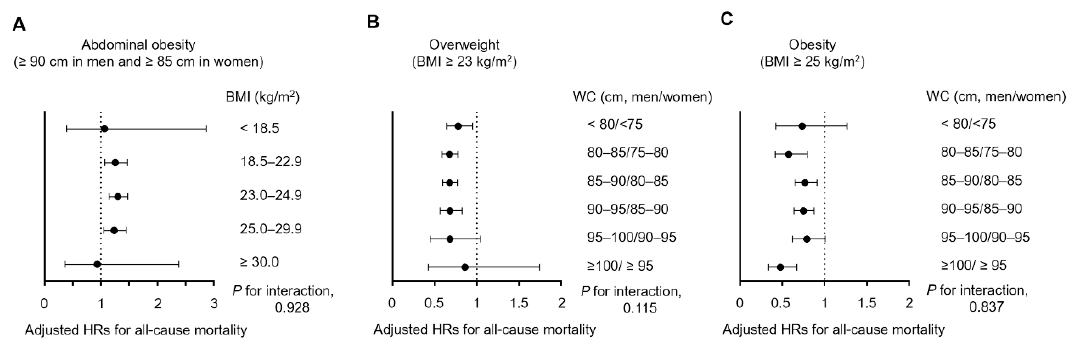
Figure 5. Subgroup analyses of the associations of ( A ) abdominal obesity, ( B ) overweight, and ( C ) obesity with all-cause mortality according to the BMI or WC group (as appropriate). BMI, body mass index; HR, hazard ratio; WC, waist